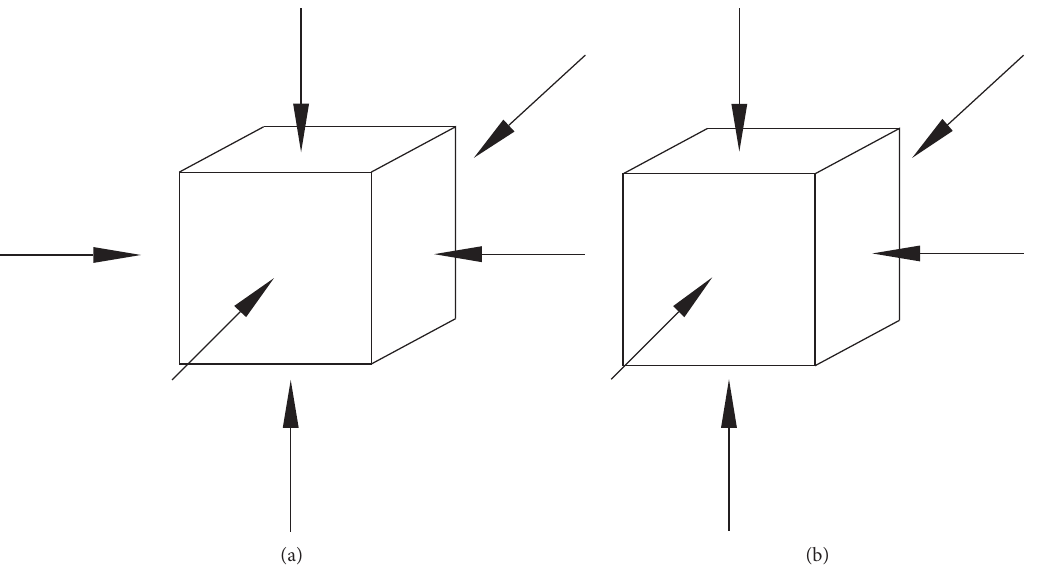
Figure 1: Stress state of surrounding rock before and after excavation. (a) Before excavation. (b) After